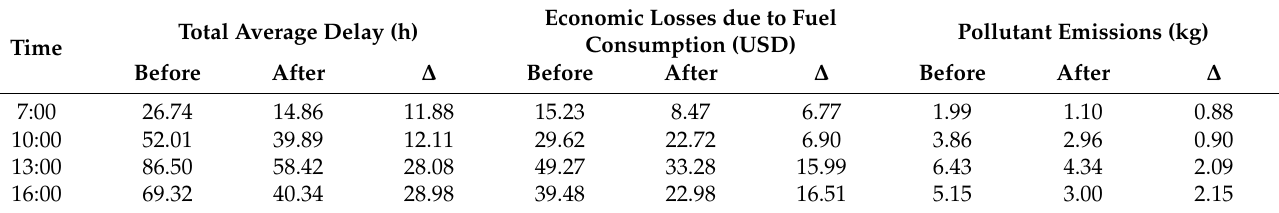
Table 3. Comparative analysis of the efficiency of the signal-controlled intersection under the current operating parameters of traffic lights and the adjustment of the cycle according to the developed methodology using an example of the left-turn direction of traffic